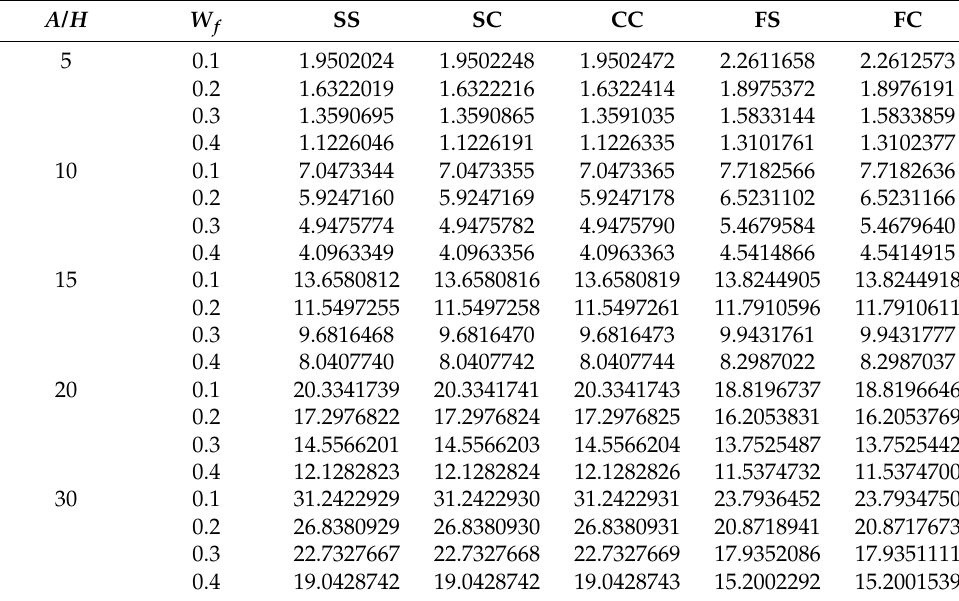
Table 4. Dimensionless central deflection W ∗ of FG porous nanocomposite piezoelectric square plates under various boundary conditions and for different values of side-to-thickness ratio A / H and GPLs weight fraction W f .